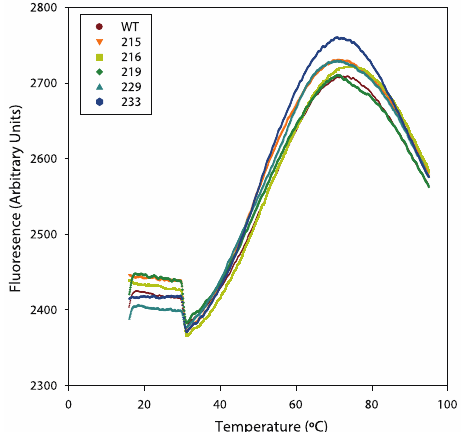
Figure 12. The thermal shifts produced by the recombinant proteins corresponding to the mutated BAG-1 variants were similar to those produced by the wild-type (WT) protein. Representative thermal shift assay data of a single batch of recombinant protein.